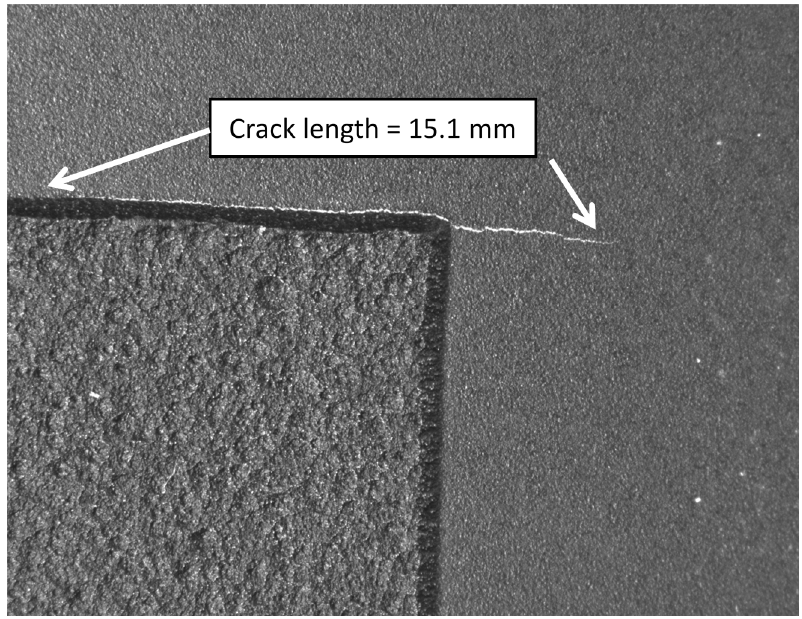
Figure 23. View of the failure location in 2024-T3 specimen.